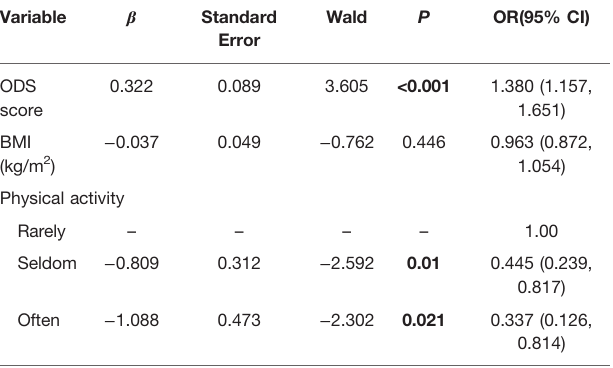
TABLE 8 | Multivariate analysis of hemorrhoid recurrence.